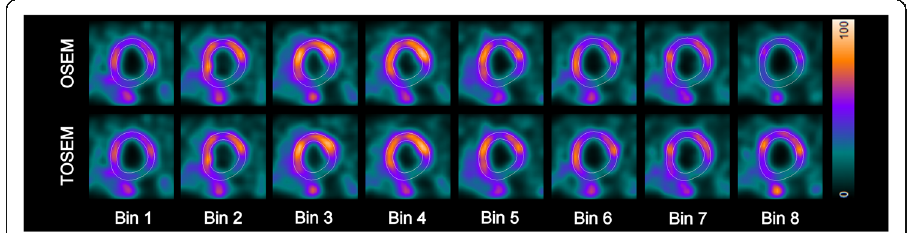
Fig. 1 Short axis views of ECG-gated patient SPECT data reconstructed with OSEM and TOSEM algorithms as displayed by Quantitative Gated SPECT 2012 program. It can be seen that the eighth bin in the OSEM- reconstructed image series has a lower activity level compared to other bins due to heart rate